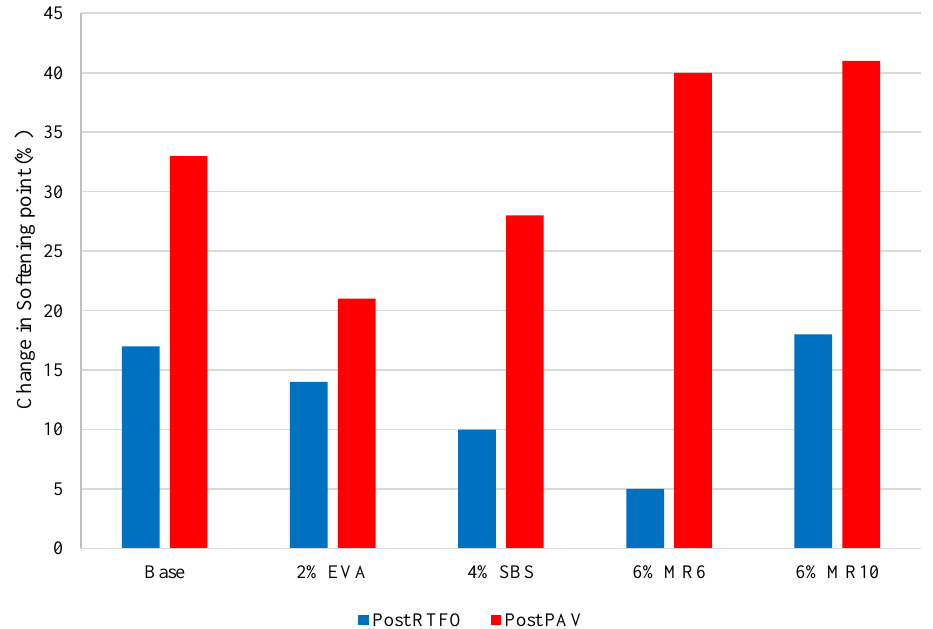
Figure 5. Change in average binder softening point before and after ageing treatments.